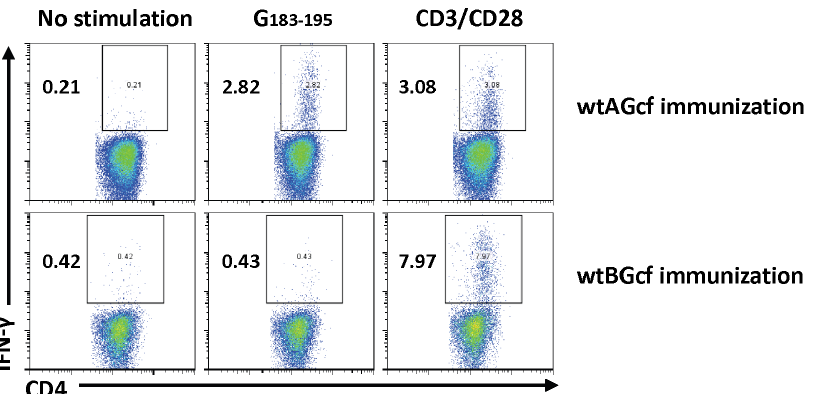
Figure 4. CD4 epitope in wtGcf. Mice were immunized twice with 20 m g of wtAGcf, or wtBGcf in the presence of 2 m g of CT sublingually in a prime-boost regimen. At day 4 post challenge with 2 6 10 6 PFU of RSV A or B subtype, respectively, lung mononuclear cells were prepared from the lung tissue and re-stimulated with G peptides (a.a. 183–195) from wtAGcf or wtBGcf or 1 m g/ml of anti-CD3 and anti-CD28 antibodies as positive control. T cell responses were measured IFN- c secreting CD4 + T cells by intracellular staining. The data are representative of three separate